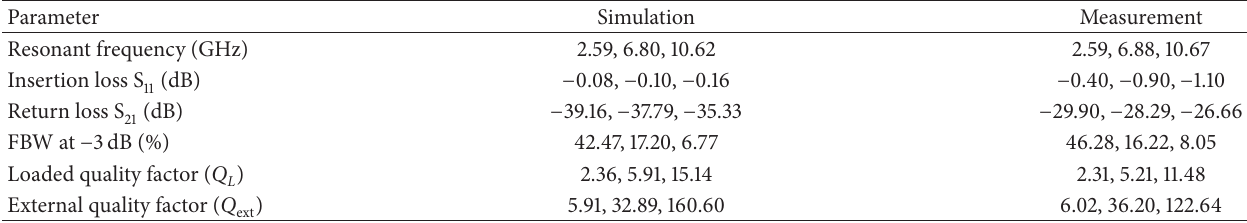
Table 2: Comparison of simulation and measurement results of the proposed symmetric TBBSF.